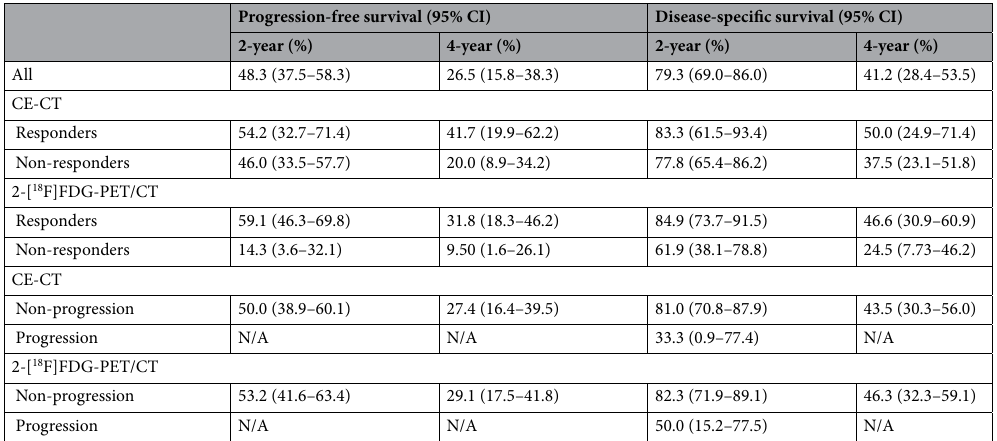
Table 3. Two- and four-year progression-free- and disease-specific survival for responders vs. non-responders and progression vs. non-progression on CE-CT and 2-[ 18 F]FDG-PET/CT (N = 87). CI confidence interval; Responders = complete (metabolic) response + partial (metabolic) response. Non-responders = stable (metabolic) disease + progressive (metabolic) disease. Progression = progressive (metabolic) disease. Non- progression = complete (metabolic) response + partial (metabolic) response + stable (metabolic)